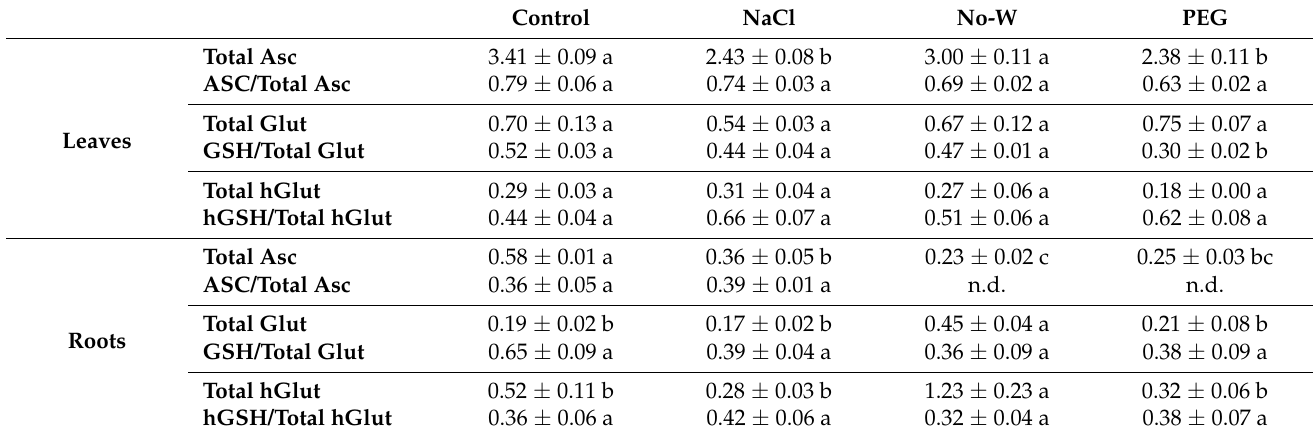
Values represent the means ± SE ( n = 5). Letters represent statistical differences (Tukey’s test, p ≤ 0.05) between treatments. No reduced nor oxidized ascorbate data could be measured in the root tissue. Asc, ascorbate; ASC, reduced ascorbate; Glut, glutathione; GSH , reduced glutathione; hGlut, homoglutathione; hGSH, reduced homoglutathione; n.d., not